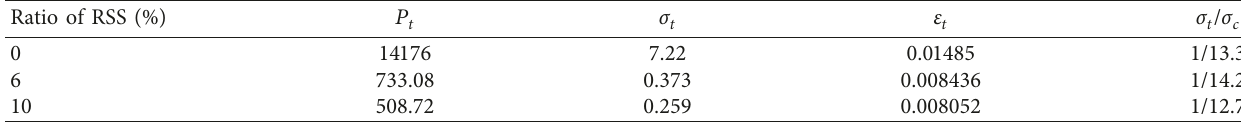
Figure 8: Tensile stress-strain curves of transparent rock specimens. (a) Without RSS. (b) With 6% RSS. (c) With 10% RSS. Table 2: Tensile mechanical parameters of transparent rock specimens.